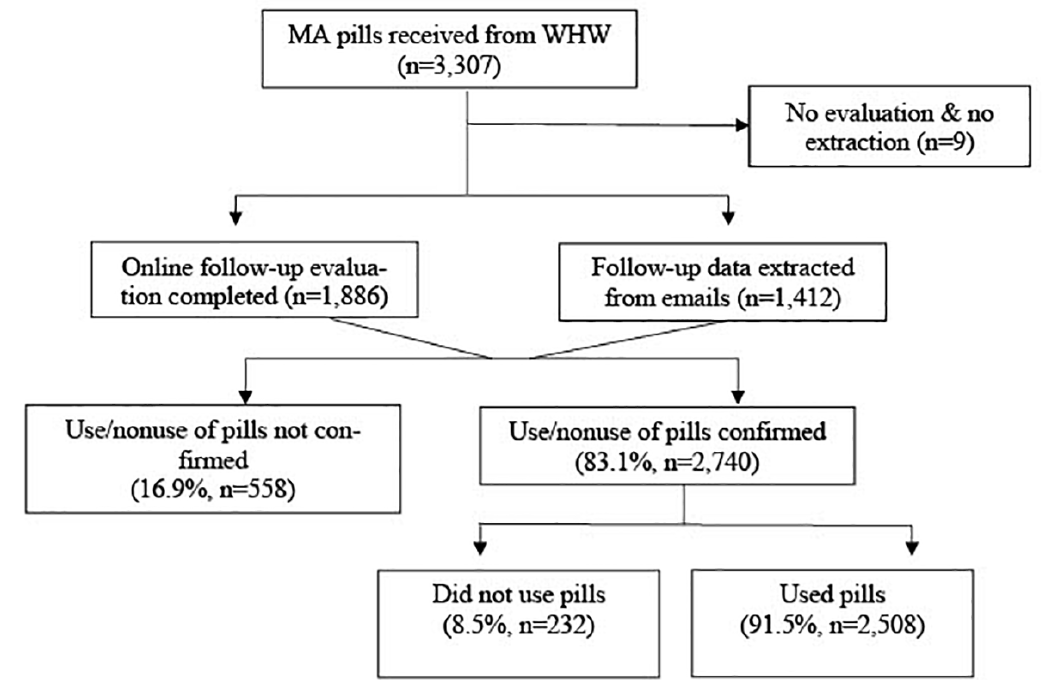
Figure 1. Participant flow of our selected